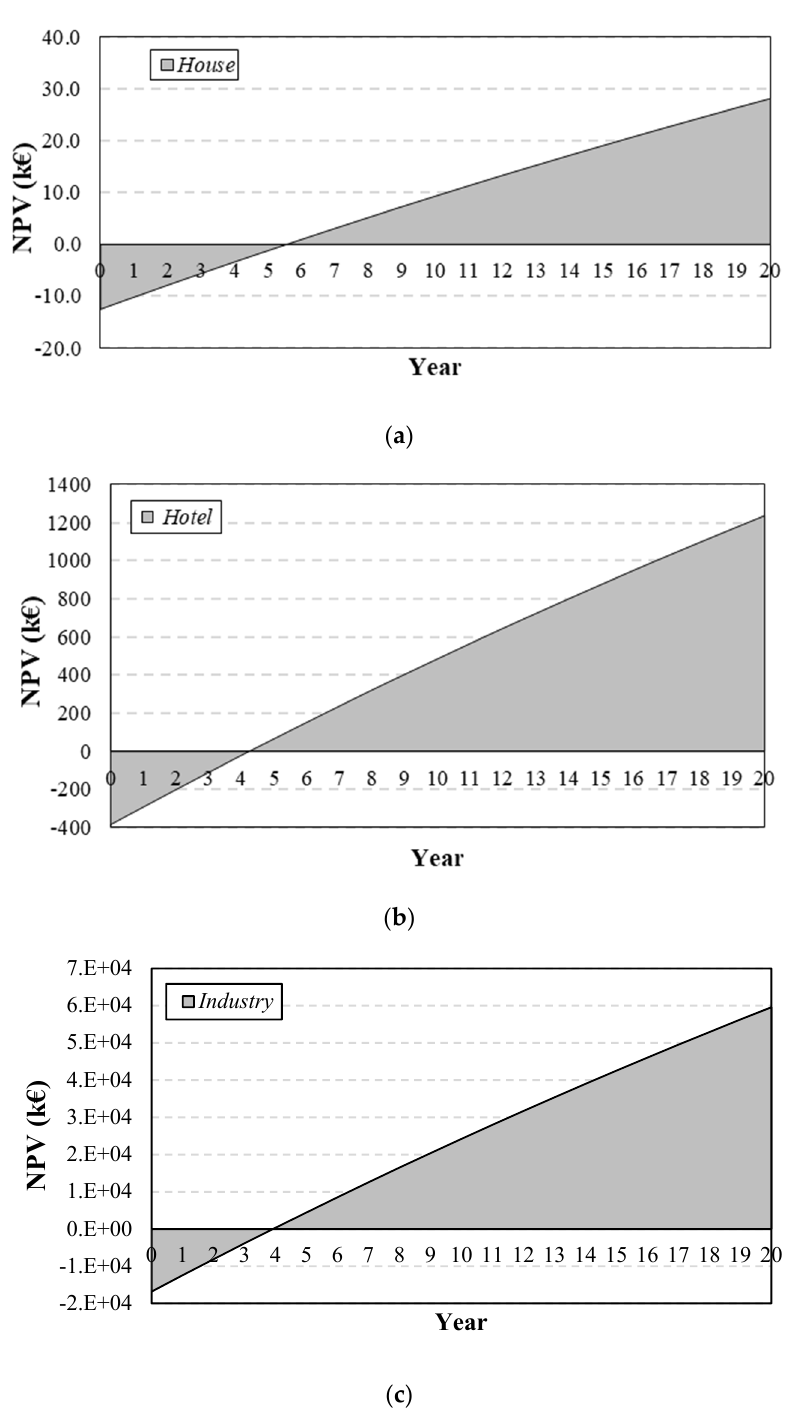
Figure 8. NPV trends over the years in correspondence of the optimal number of modules for the three users defined: ( a ) house; ( b ) hotel; and ( c ) industry.